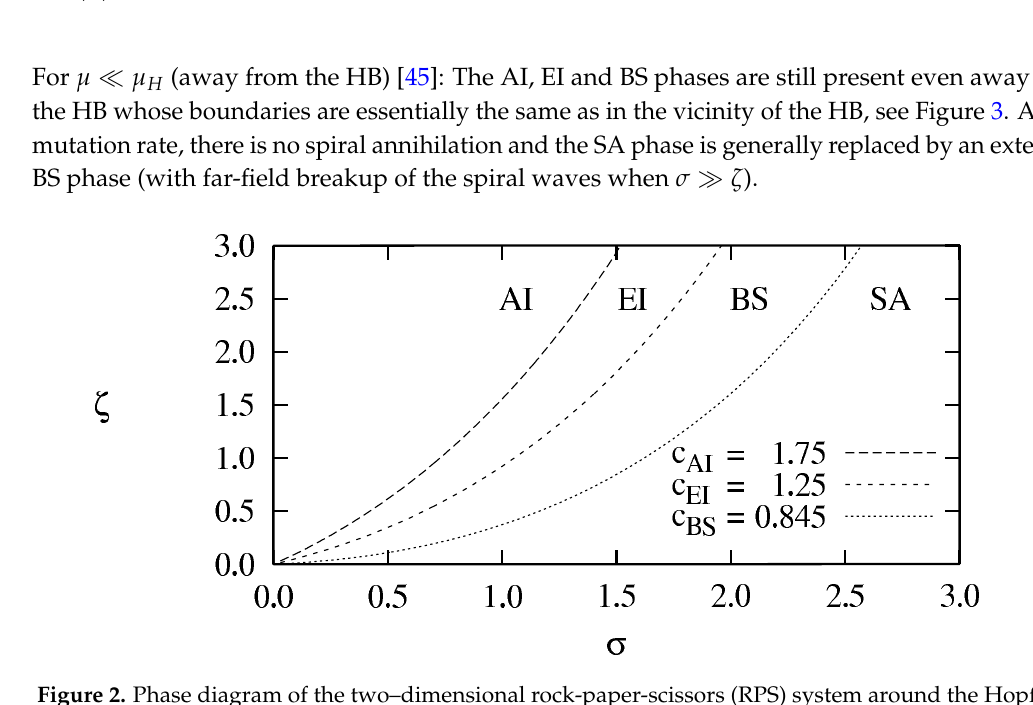
Figure 2. Phase diagram of the two–dimensional rock-paper-scissors (RPS) system around the Hopf bifurcation with contours of c = ( c AI , c EI , c BS ) in the σ − ζ plane, see text. We distinguish four phases: spiral waves are unstable in absolute instability (AI), Eckhaus instability (EI) and spiral annihilation (SA) phases, while they are stable in bound state (BS) phase. The boundaries between the phases have been obtained using the CGLE parameter (6). Adapted from [45].